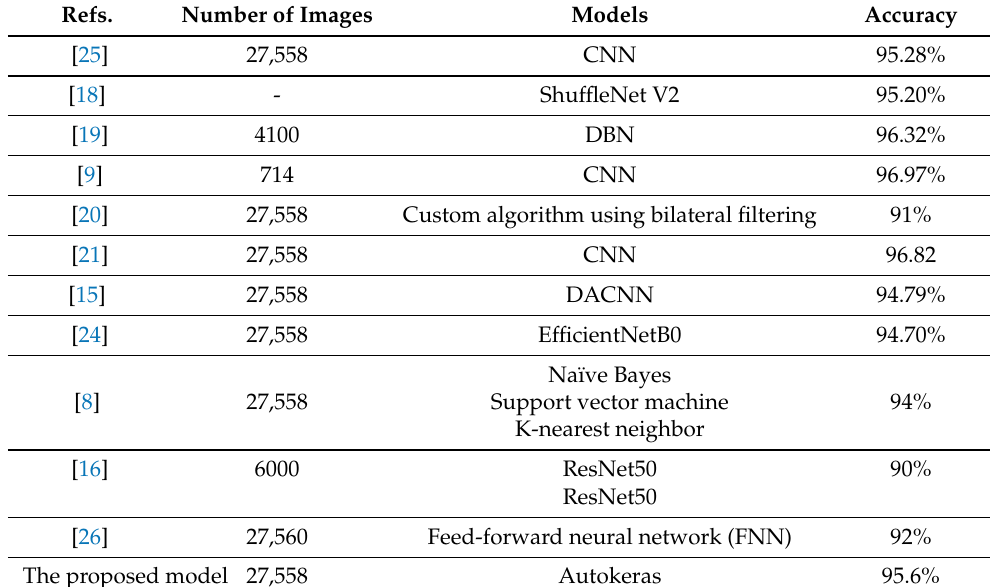
Table 3. Comparison between the Autokeras model and previous works.